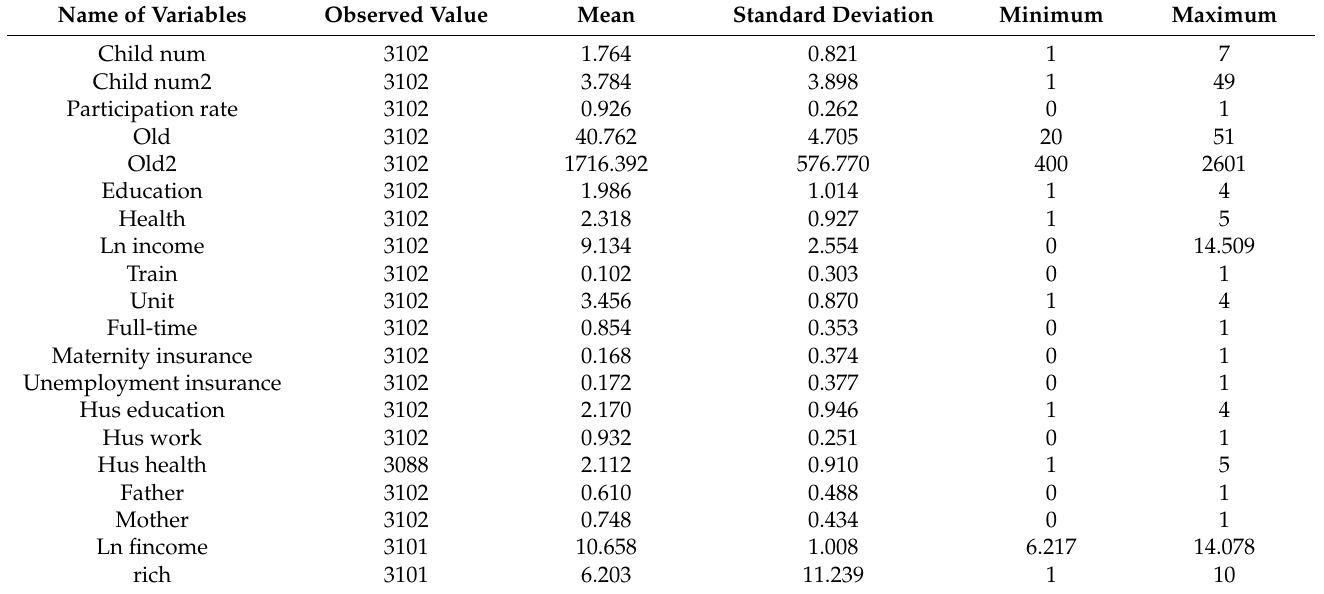
Table 2. Descriptive statistical results of